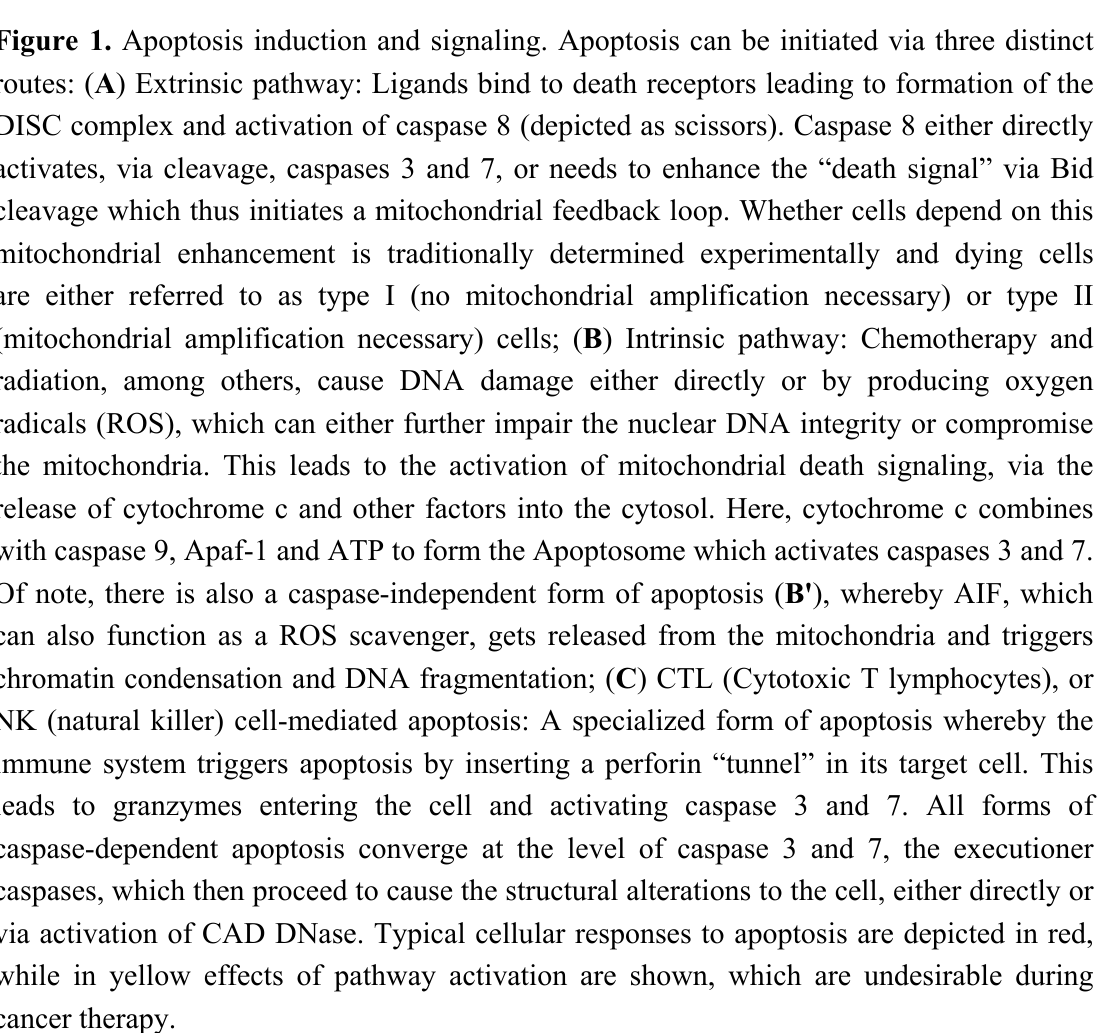
Figure 1. Apoptosis induction and signaling. Apoptosis can be initiated via three